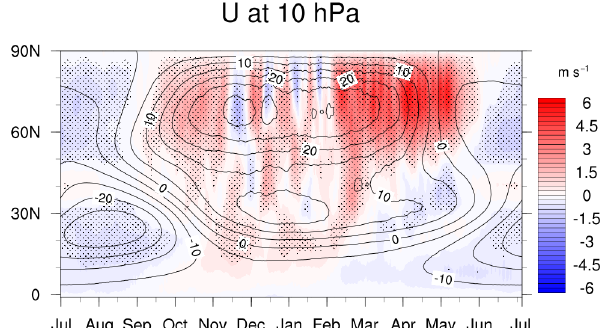
Figure 1. Latitude–time plot of zonal mean zonal wind ( U ) at 10hPa. Contours show NOCHEM values (in ms − 1 ). Colored shad- ing shows the CHEM-NOCHEM difference (in ms − 1 ). Stippling indicates a significant CHEM-NOCHEM difference at a 95% level using a two-tailed, two-sample Welsh’s t